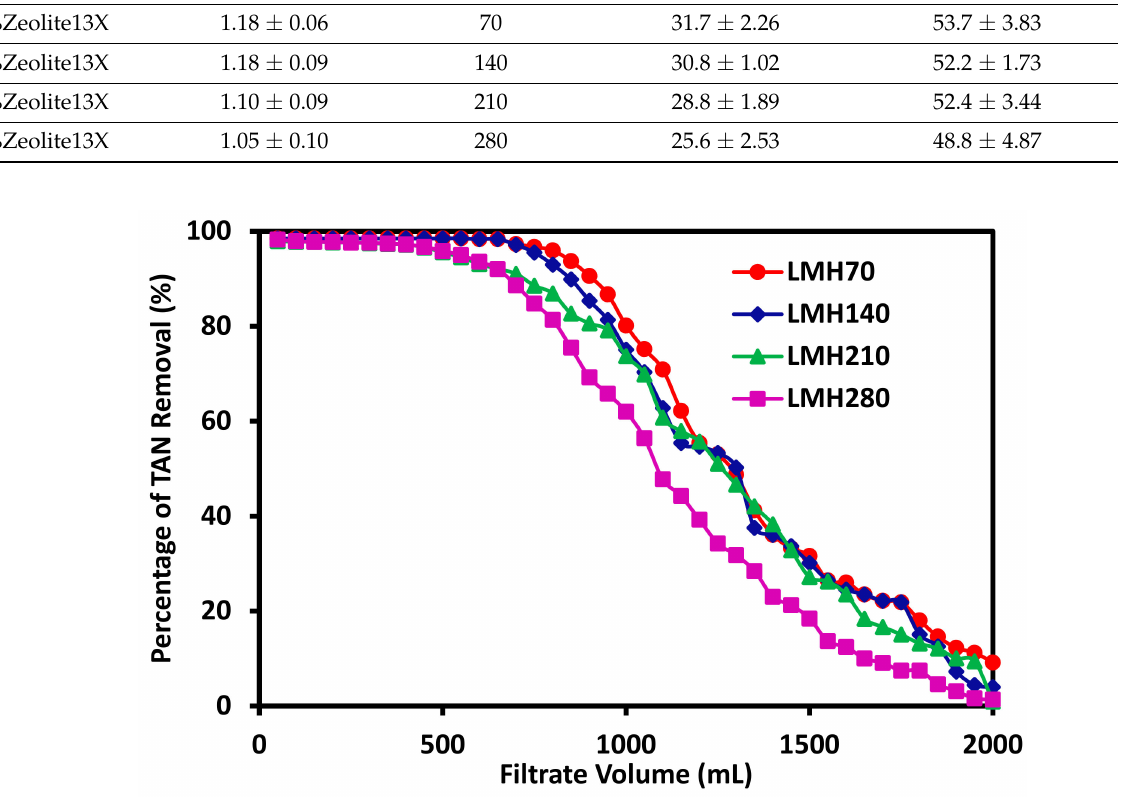
Figure 4. Variation of TAN removal rate with filtration flux with a 2000 mL feed containing 6 ppm TAN for the fabricated membranes with the same composition but slightly different weight as shown in Table